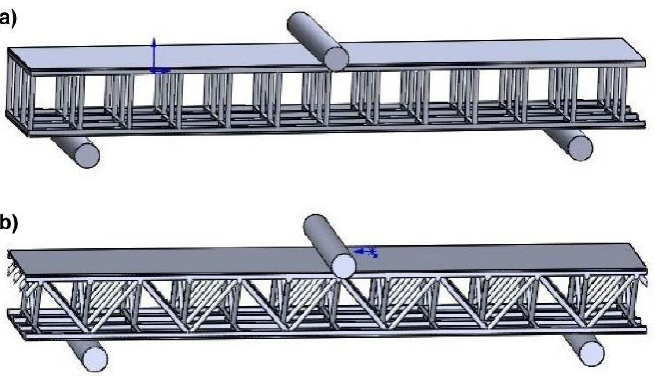
ture was divided into a 2.5 mm tetrahedral mesh. A 3 mm hexahedral mesh was created